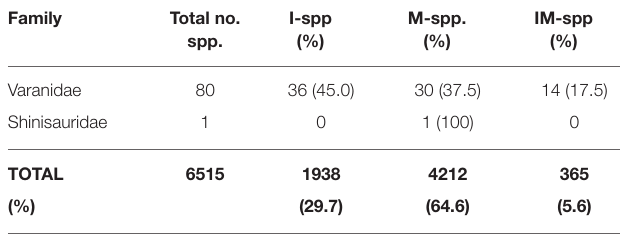
Family Total no.